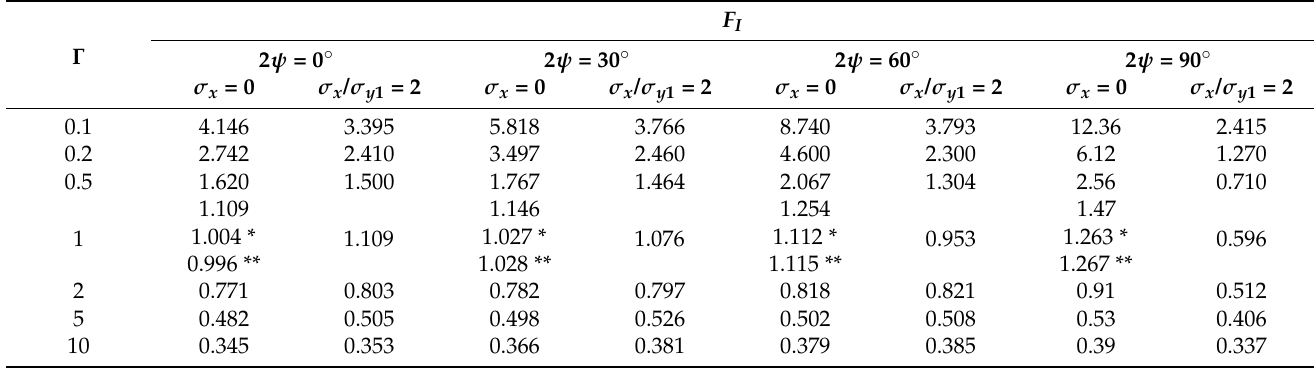
Table 5. Values of normalised stress intensity factors F I calculated for the rectangular plate with a central sharp corner under uniaxial/biaxial tension, a / w = 0.4.